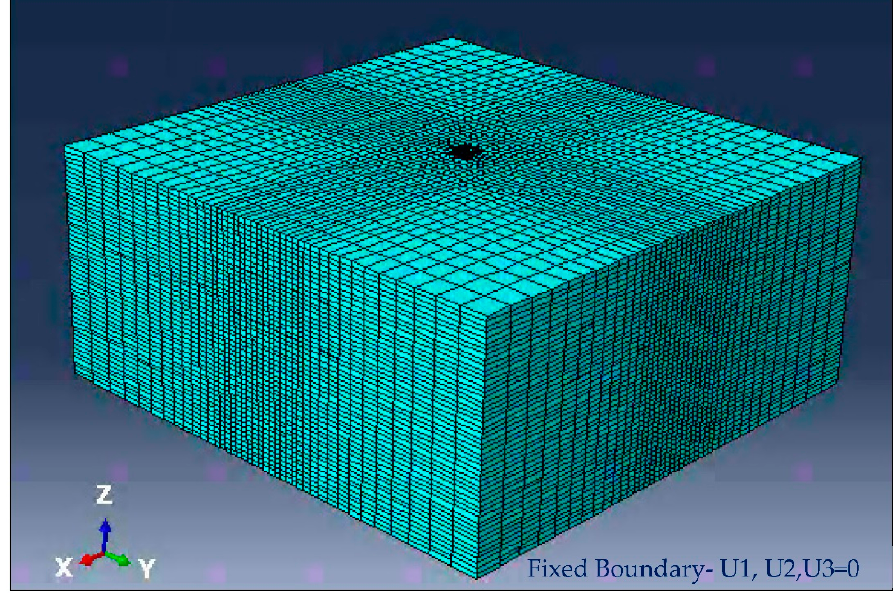
Figure 7. Three-dimensional finite element mesh and boundary